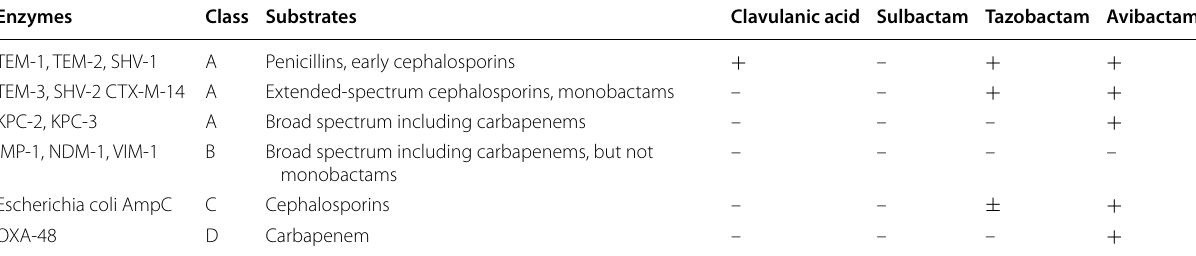
Table 4 (Adapted from Bonomo and Van Duin) Activity in clinical practice of different beta-lactamase inhibitors, accord- ing to type of enzymes [68,